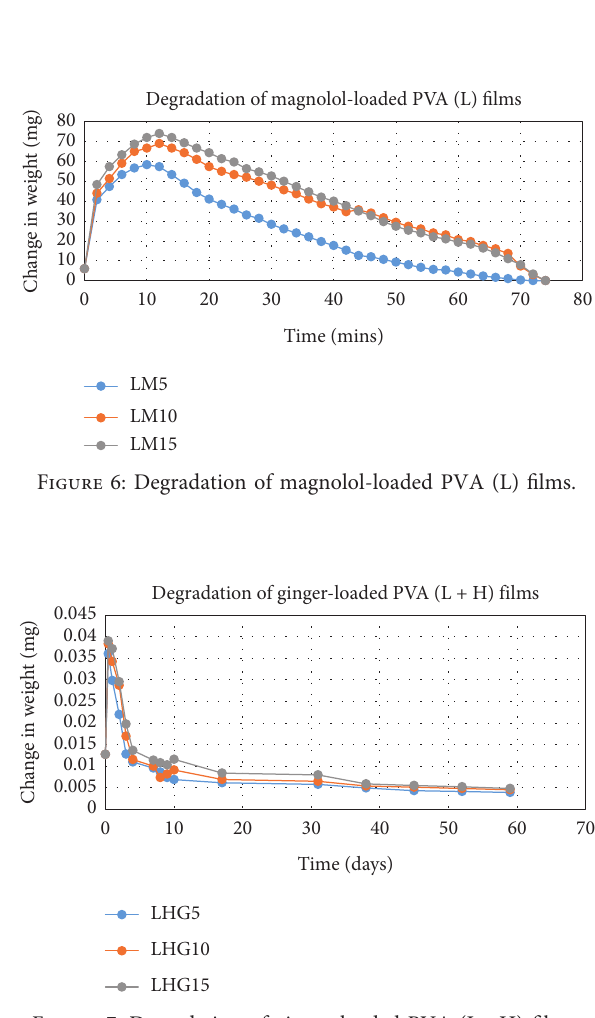
Figure 7: Degradation of ginger-loaded PVA (L+H) films.